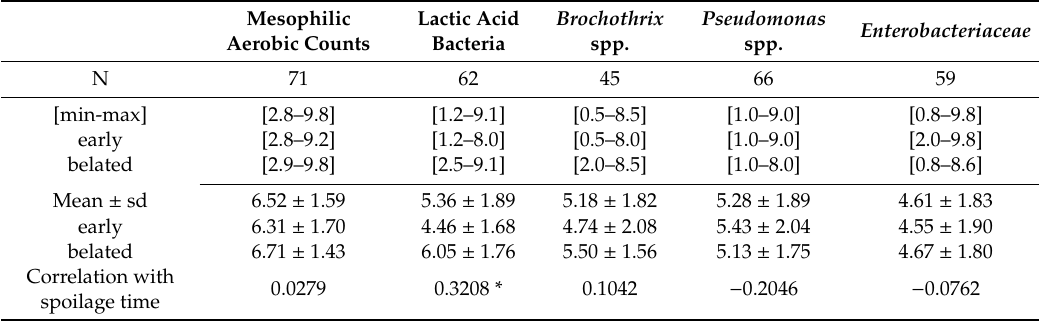
Table 3. Enumeration of di ff erent bacterial groups at the spoilage occurrence time (overall, early and belated spoilage). N, total number of experimental data collected from all studies.